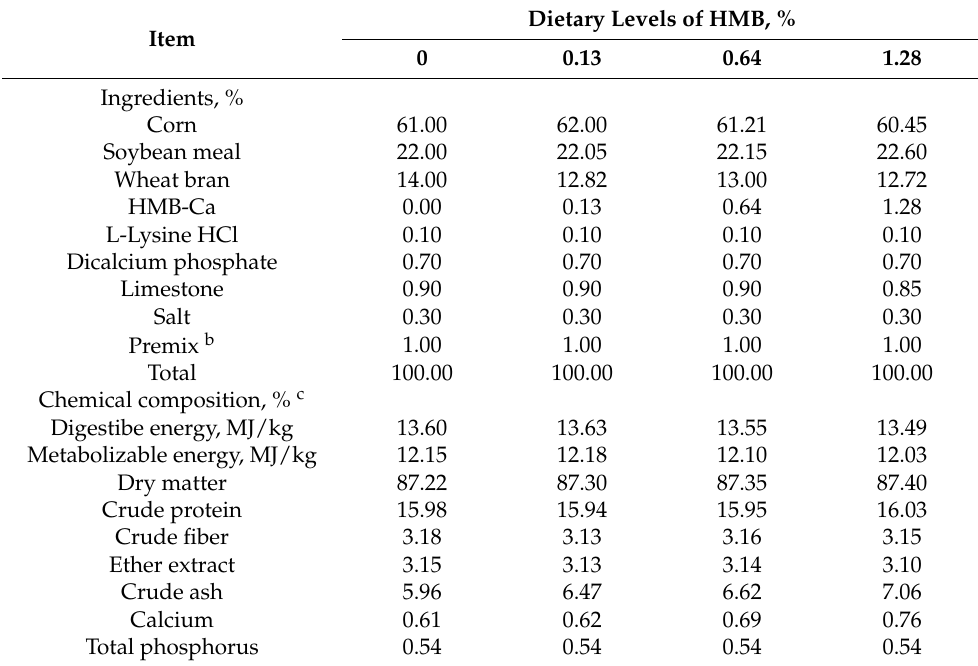
Dietary Levels of HMB,